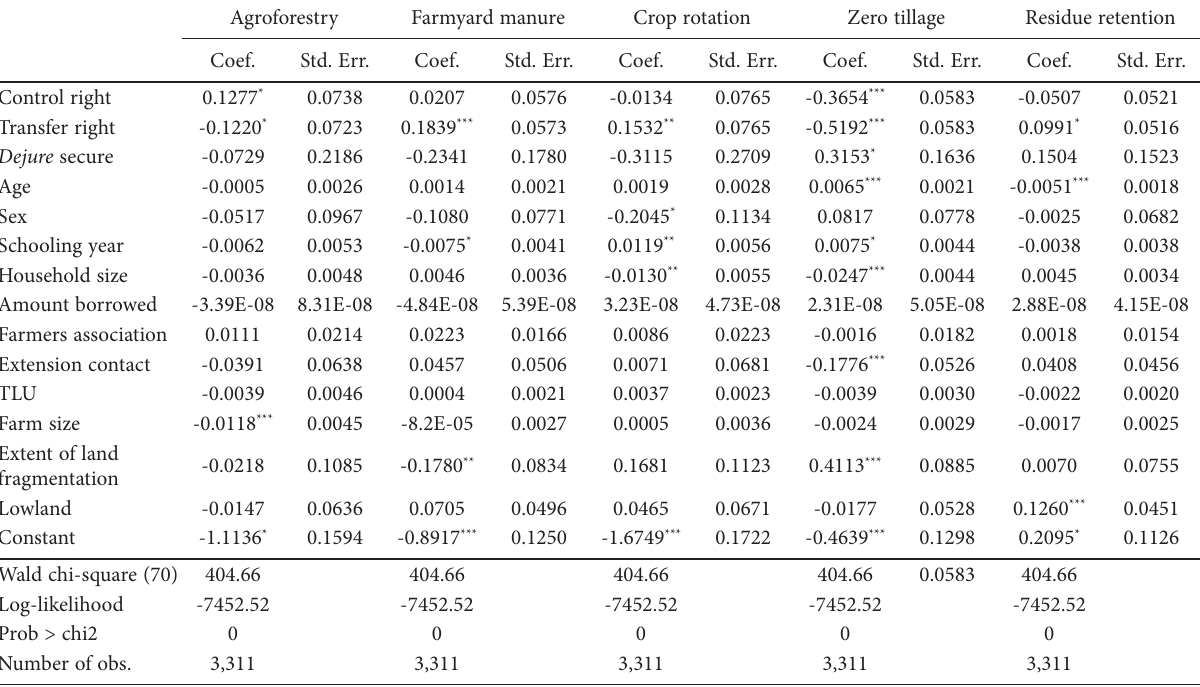
Table 4. Influence of LTPRs on adoption of climate-smart practices among smallholder farmers: multivariate probit estimates. Agroforestry